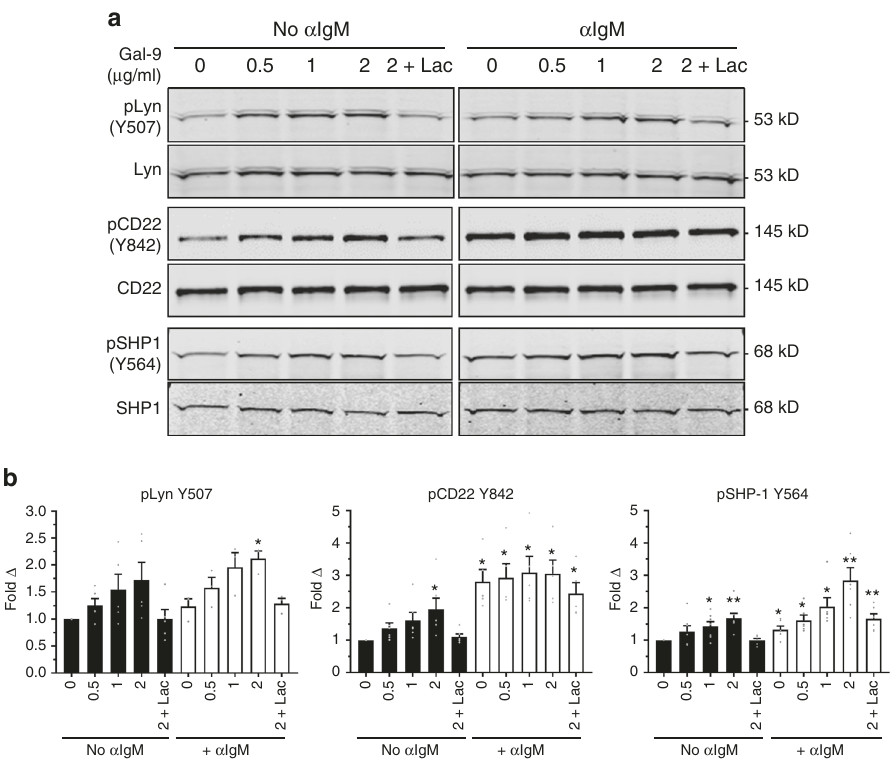
Fig. 4 Gal-9 induces phosphorylation of Lyn, CD22, and SHP-1 in naive B cells. a Representative western blot and b quanti fi cation of Lyn, CD22, or SHP-1 phosphorylation at the indicated sites in magnetically enriched naive B cells treated with recombinant Gal-9 at the indicated concentrations in the absence (left blot) or presence (right blot) of anti-IgM F(ab ’ ) 2 -mediated crosslinking (15 μ g mL − 1 ) for 5 min. Blots were subsequently stripped and reprobed with antibody against total protein. Data in b were normalized to respective total protein control and are presented relative to no stimulation control. In all experiments, no IgM and IgM-stimulation lanes were loaded on the same gel and probed on the same blot. For a , data are representative of results from four independent experiments. For b , n = 3 or more distinct tonsil specimens pooled from three or more independent experiments. Statistics were calculated using a one-sample t -test against a hypothetical value of 1. Throughout, bars and error bars depict mean and SEM, respectively. ns =